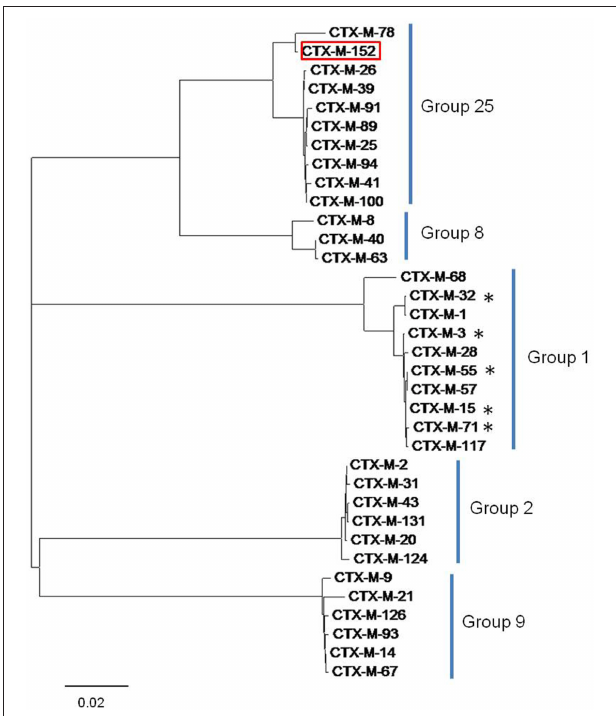
FIGURE 2 | Tree diagram showing similarity among the CTX-M lineage enzymes and clustering of different CTX-M group members. The tree was constructed with the MEGA6 software. The variant CTX-M-152 is highlighted red and variants identified in this study are marked by asterisk.